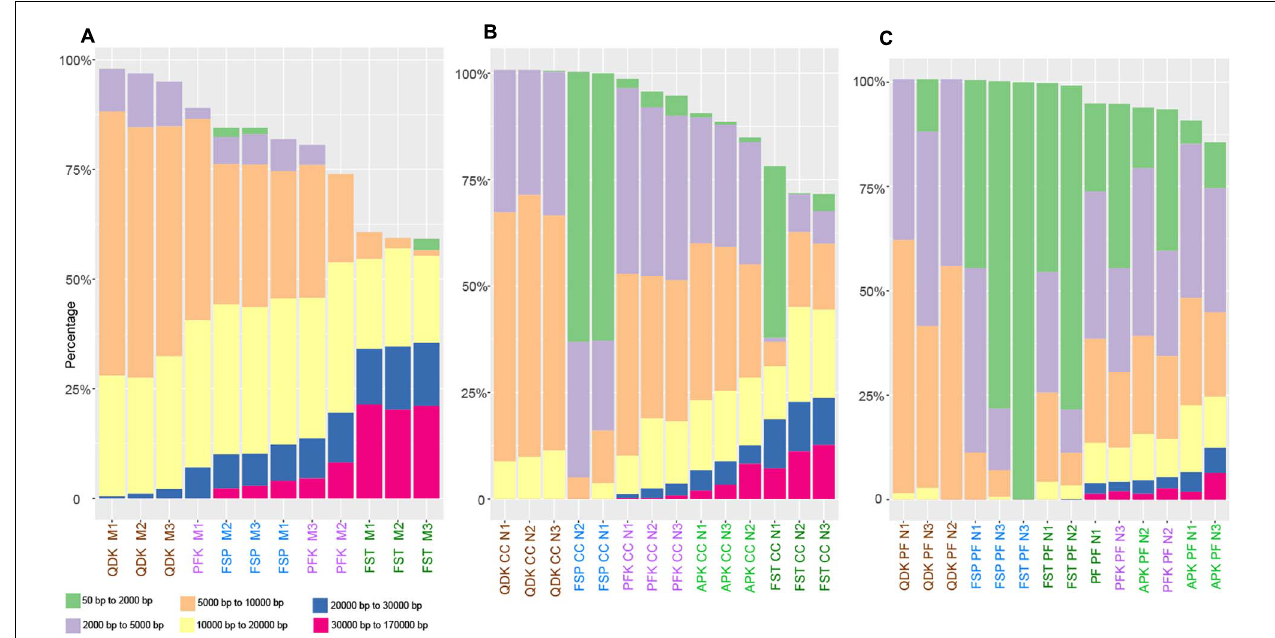
FIGURE 3 | Fragmentation profiles of DNA extracted by different isolation kits. Mock community DNA (A) , as well as DNA extracted from chicken cecum (B) and pig feces (C) was subjected to analysis on an Agilent Fragment Analyzer System. The different user defined size classes are plotted as stacked bars representing % of total DNA. Samples with DNA concentrations below 0.4 ng µ L − 1 were excluded from the